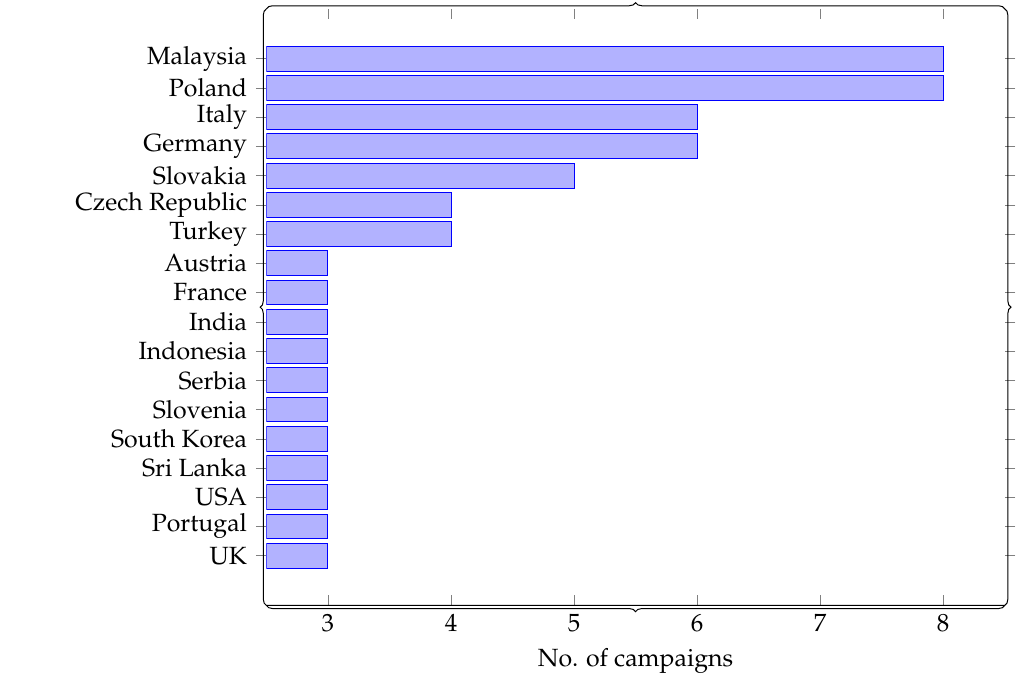
Figure 5. Countries involved in assessment campaigns. Table 2. Top 5 countries. Country